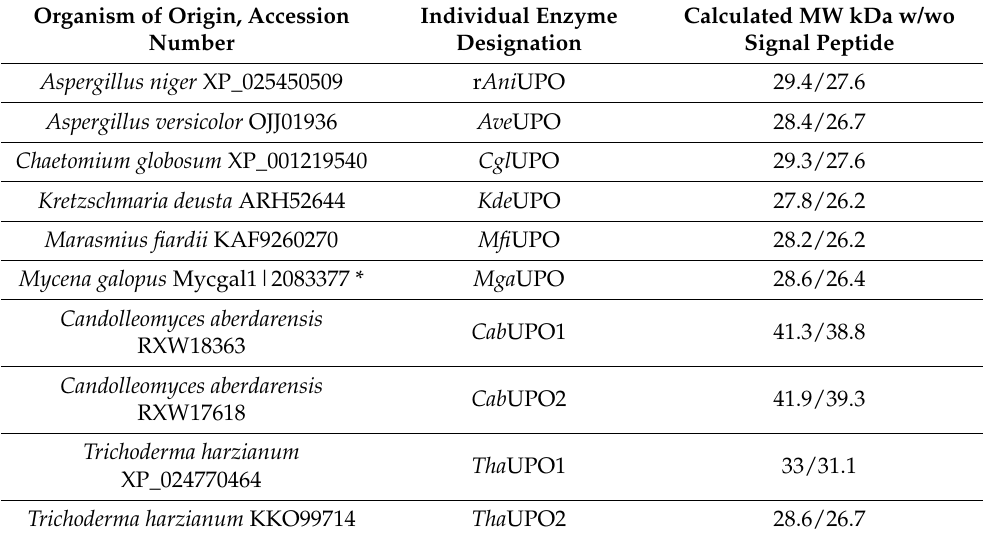
Table 1. Investigated UPOs for recombinant expression in P. pastoris